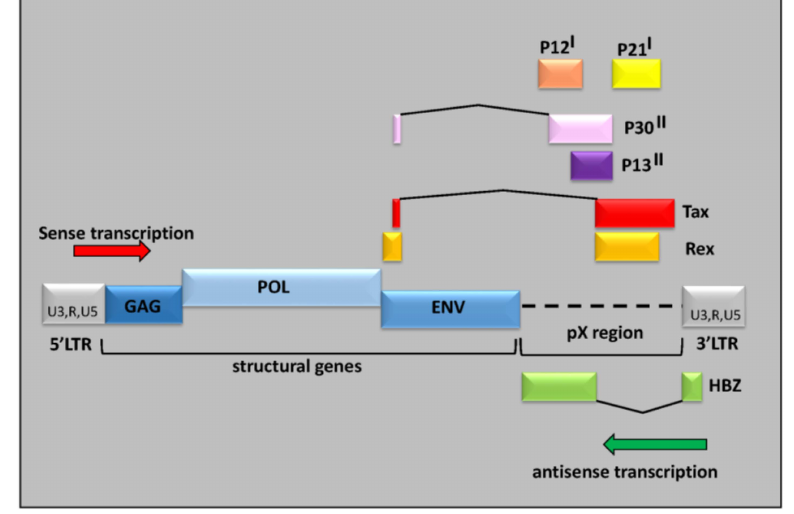
Figure 1. Structure of the HTLV-1 provirus: The human T-cell leukemia virus type 1 (HTLV-1) genome encodes for three structural proteins, Gag, Pol, and Env, and complex regulatory proteins such as Tax, which not only activates viral replication, but also induces the expression of several cellular genes. The in vivo expression of these viral proteins is suppressed by cytotoxic T lymphocyte (CTL) activity. HTLV-1 basic Zip factor (HBZ), produced by a minus-strand mRNA, likely plays a role in viral replication and T-cell proliferation as it is steadily expressed in most HTLV-1-infected cells and primary adult T-cell leukemia (ATL) cells, whereas Tax is